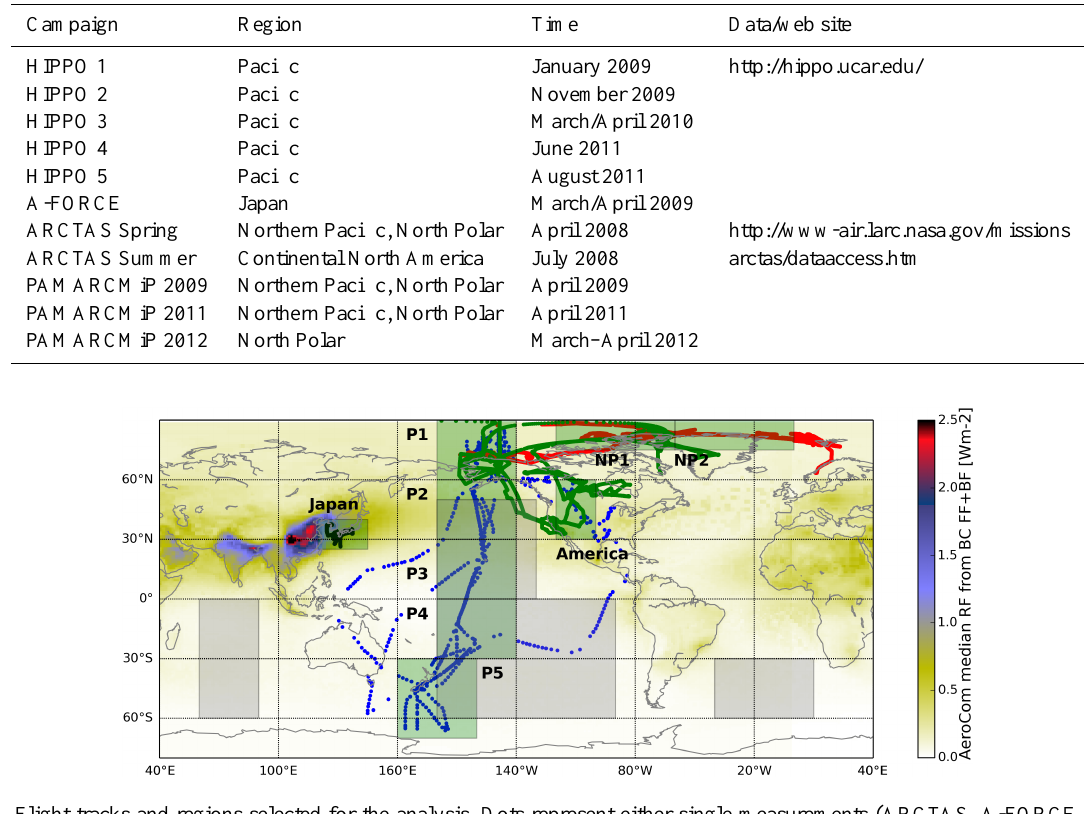
Table 1. The flight campaigns included in the present work, and the times when they flew.